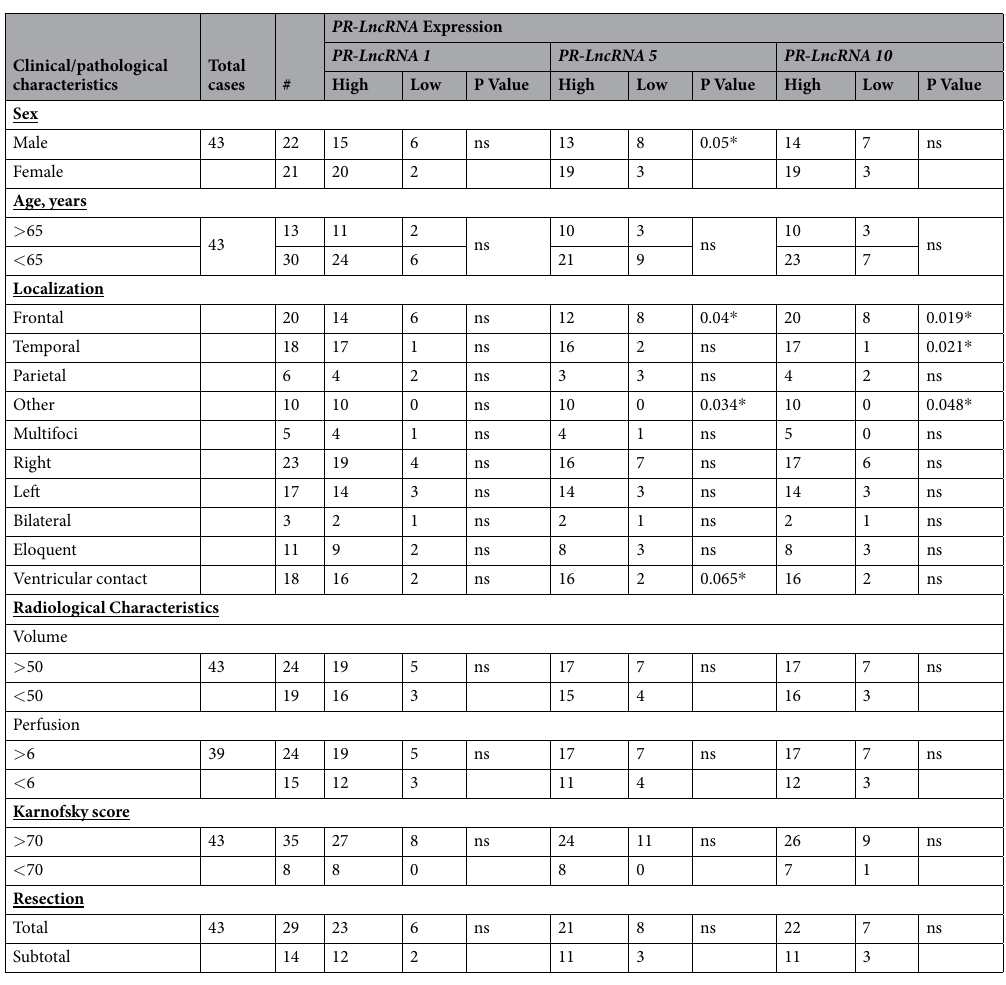
Table 3. Correlation between PR-LncRNA and clinical characteristics in the glioma